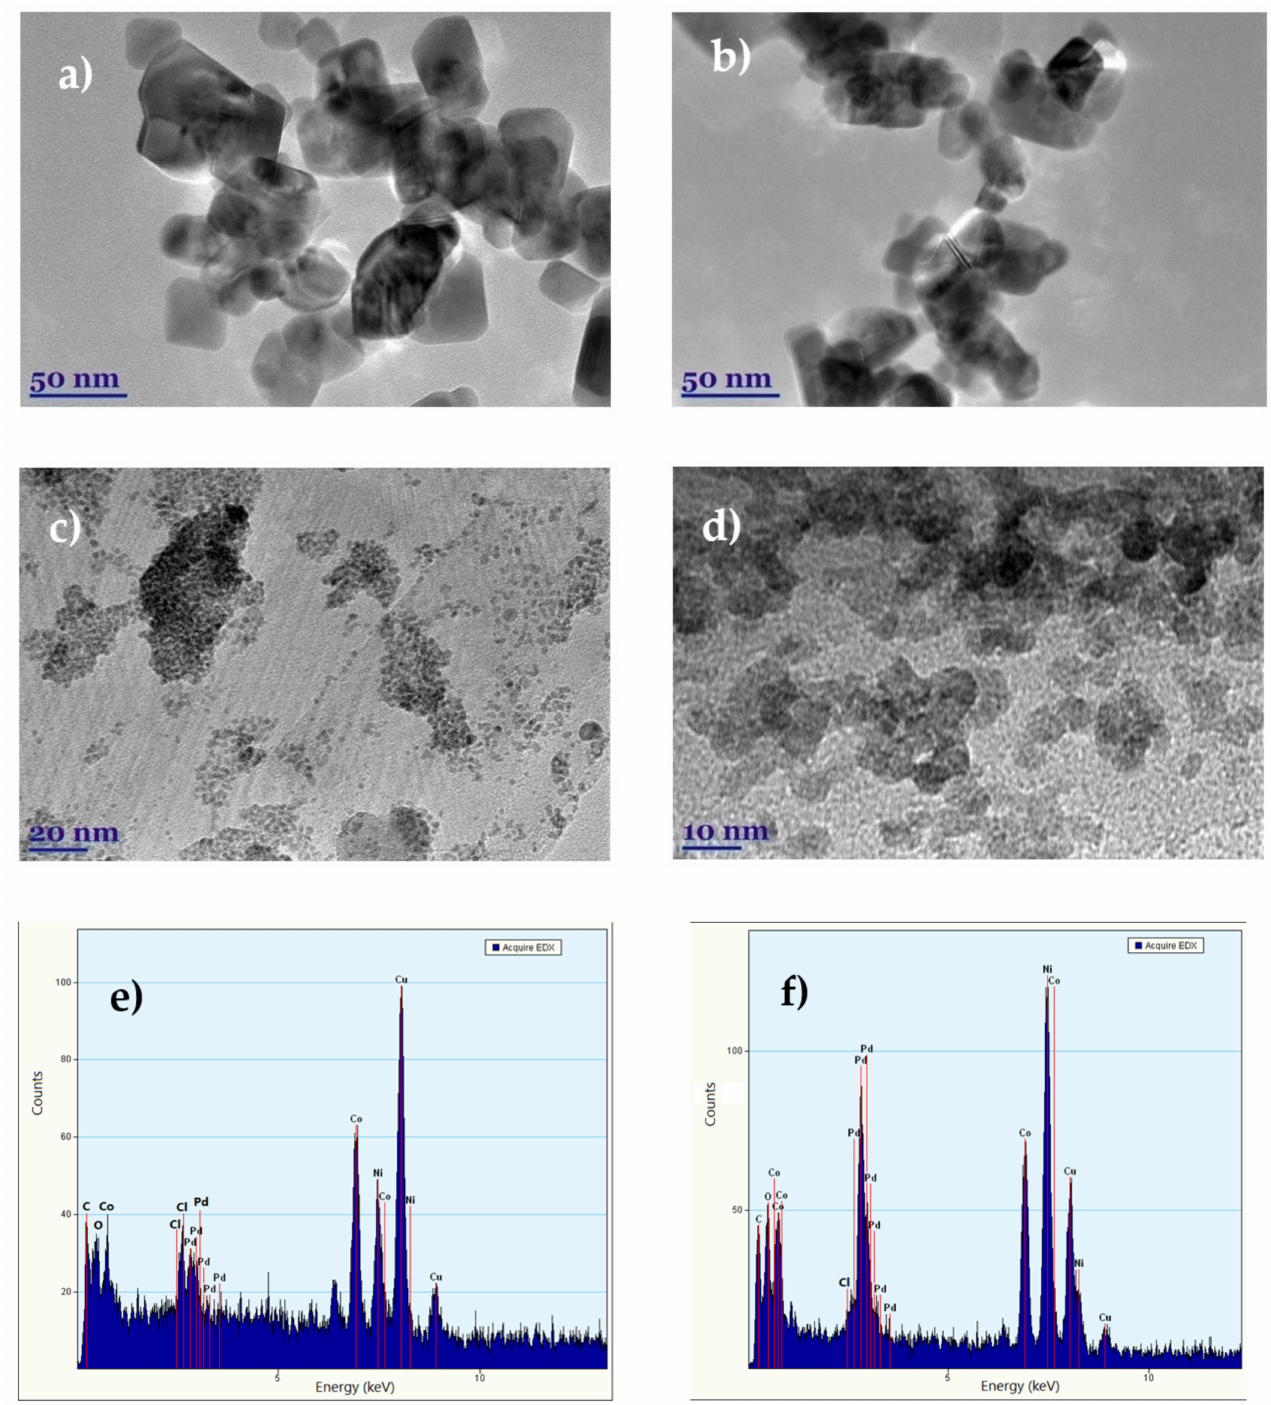
Figure 4. TEM images of the Co 3 O 4 /C ( a ), Co 3 O 4 /C-T ( b ), Pd-Cl 2 -Co 3 O 4 /C ( c ), and PdOCo 3 O 4 /C ( d ) catalysts. EDX analysis of Pd-Cl 2 -Co 3 O 4 /C ( e ) and PdOCo 3 O 4 /C ( f )